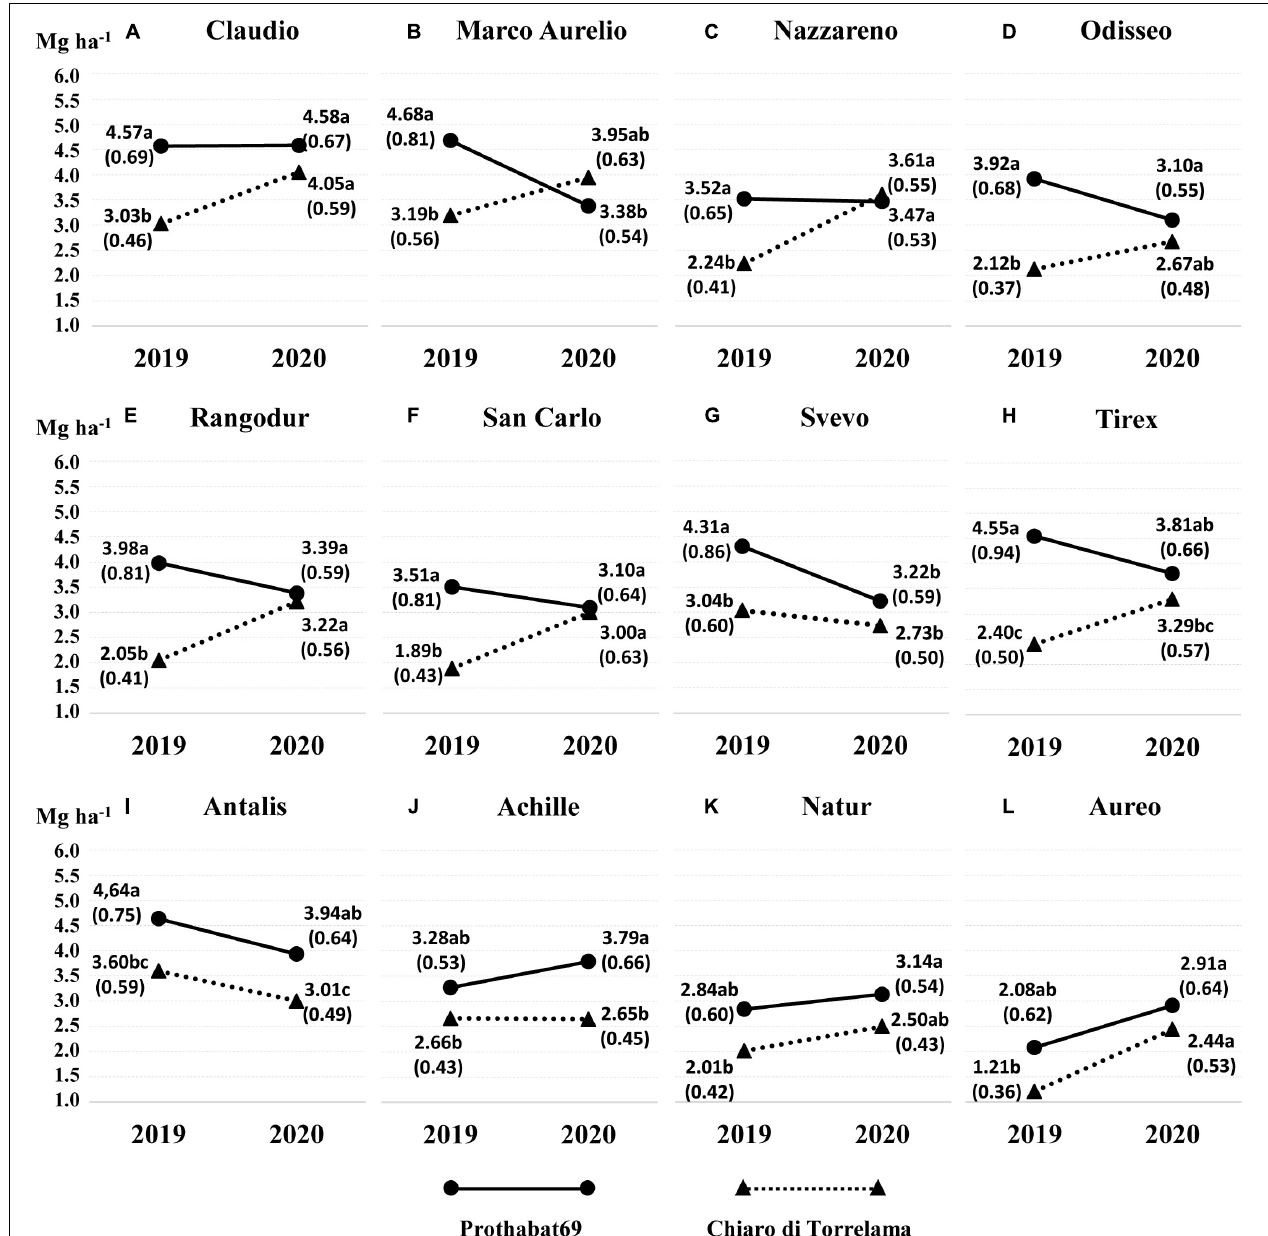
FIGURE 1 | Grain yield in 2019 and 2020 of each durum wheat variety (A–L) in mixed cropping with two faba bean varieties (Chiaro di Torrelama and Prothabat69). Means followed by different letters are significantly different ( P < 0.05). In parenthesis, the land equivalent ratio (LER) of wheat (LER w ) values are